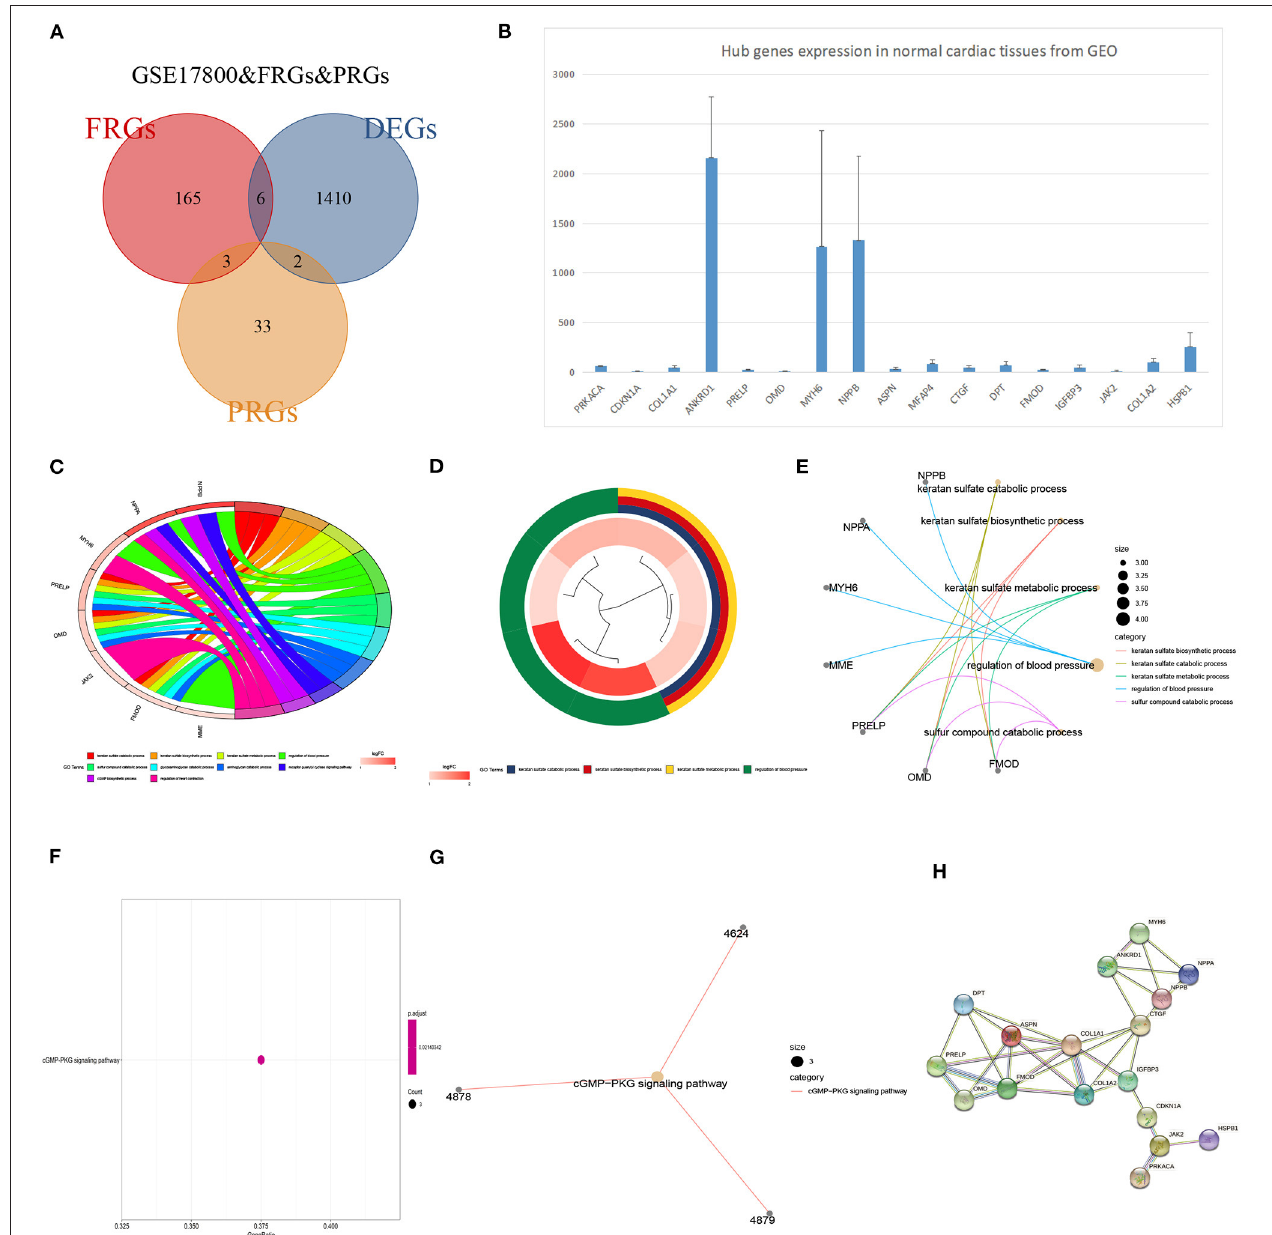
FIGURE 6 | The identification of DCM related genes and their functional analysis. (A) Venn diagram of ferroptosis-related genes, pyroptosis-related genes and DEGs in GSE17800. (B) The expression of potential biomarker genes including top 25 genes validated in GSE17800 and overlapping DEGs of ferroptosis-related genes, pyroptosis-related genes based on NCBI. (C) Chord plot shows the distribution of core genes in different GO-enriched functions. Symbols of core genes are presented on the left side of the graph with their fold change values mapped by color scale. (D) The top three significantly enriched Gene Ontology terms associated with potential biomarker genes. Gene involvement in the GO terms was determined by colored connecting lines. (E) Cluego network diagram shows the relationship between the potential biomarker genes and GO terms. (F) The bubble chart showed the KEGG pathway analyses of potential biomarker genes in DCM. (G) Cluego network diagram shows the relationship between the potential biomarker genes and KEGG terms. (H) PPI network of 18 potential biomarker genes.